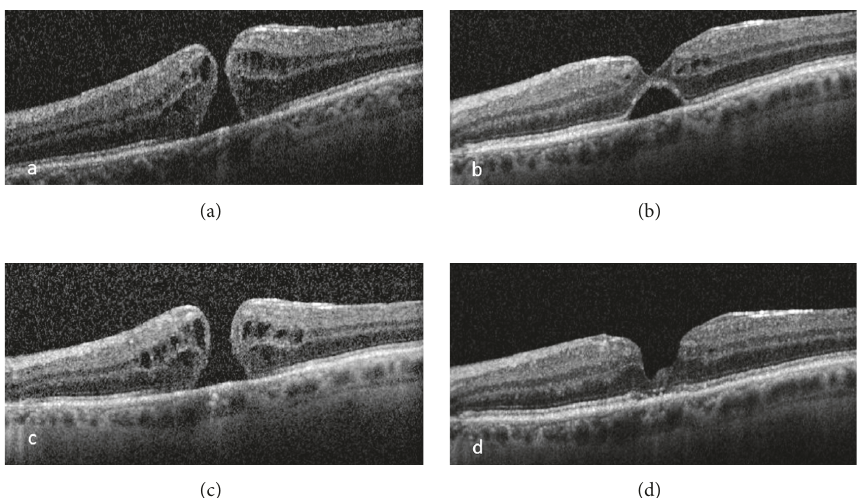
Figure 1: Optical coherence tomography showing (a) full thickness macular hole, (b) first closure of macular hole with residual subretinal fluid, (c) reopening of macular hole, and (d) second closure of the macular hole.